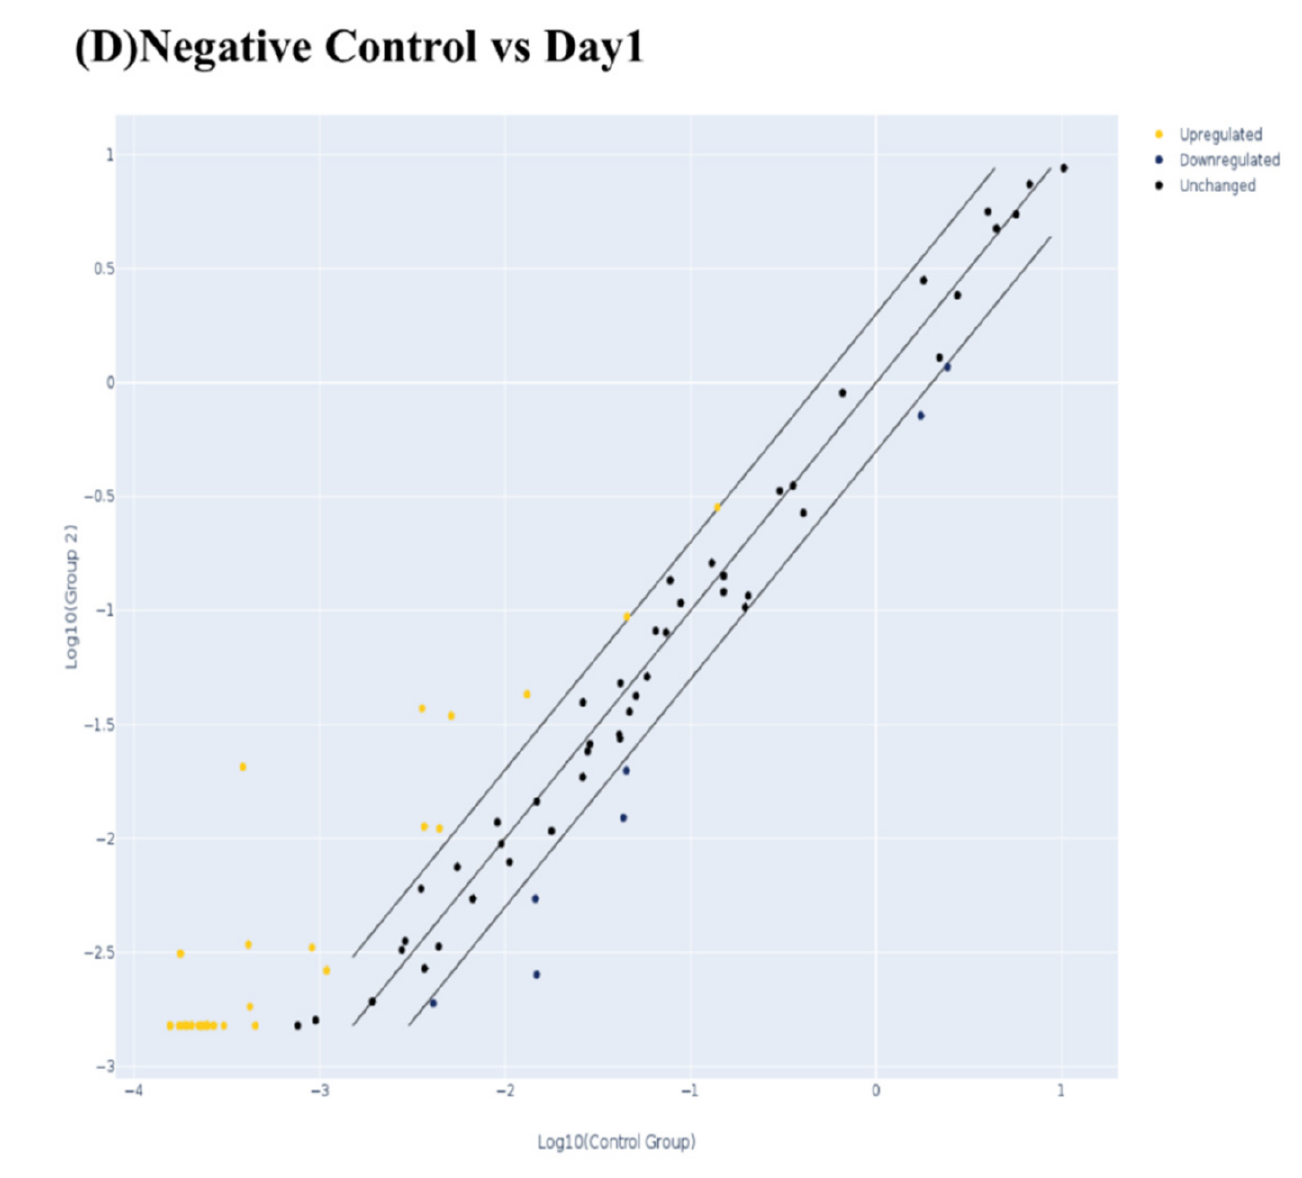
Figure 3. Evaluation of human odonto/osteogenesis pathway by quantitative PCR array. ( A ) Heat map of gene expression levels in human odonto/osteogenesis pathway in hDPSCs treated with Biodentine, osteogenic differentiation media (positive control), and uninduced cells, cultured in their own growth media (negative control), compared to day 1 of treatment. Scatter plots of odonto/osteogenesis signaling pathway in hDPSCs treated with ( B ) Biodentine, ( C ) osteogenic differentiation media (positive control), and ( D ) uninduced cells, cultured in their own growth media (negative control), compared to day 1 of treatment. A cut-off point of two-fold change in expression was utilized. Yellow dots indicate the genes that were upregulated; blue dots indicate the genes that were downregulated; and black dots indicate the unchanged